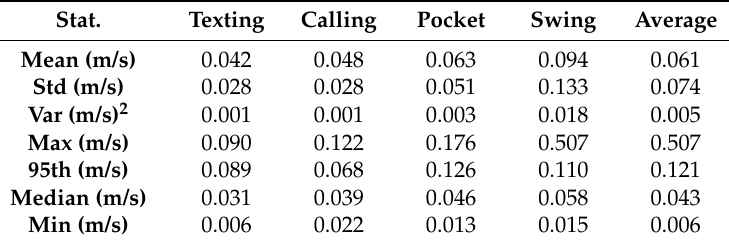
Table 9. Walking speed estimation error of the different pose.